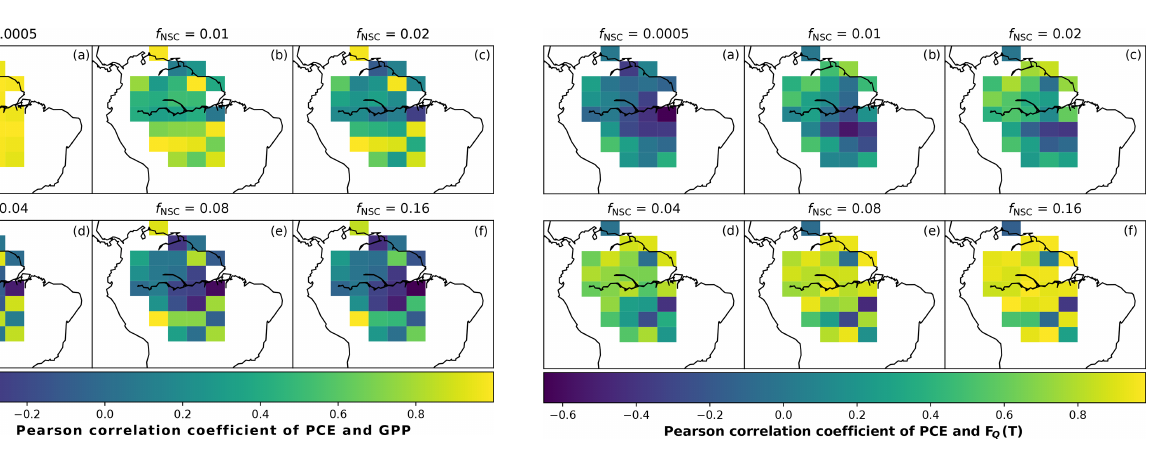
nual mean PCE in SUGAR is 22 . 82 ± 0 . 76 MgCha − 1 yr −